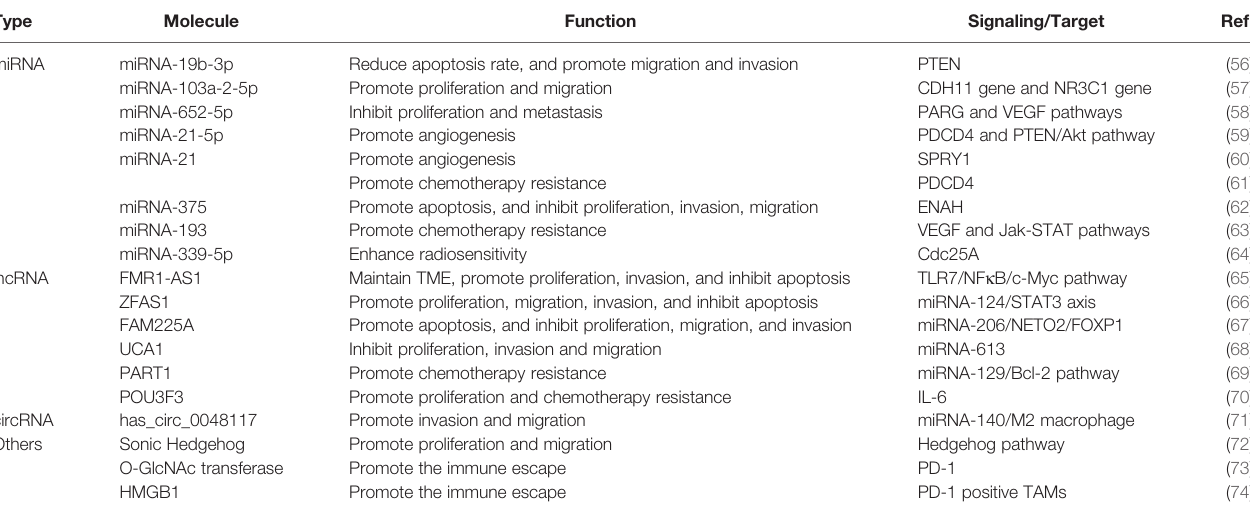
TABLE 1 | Roles of exosome in the initiation and development of